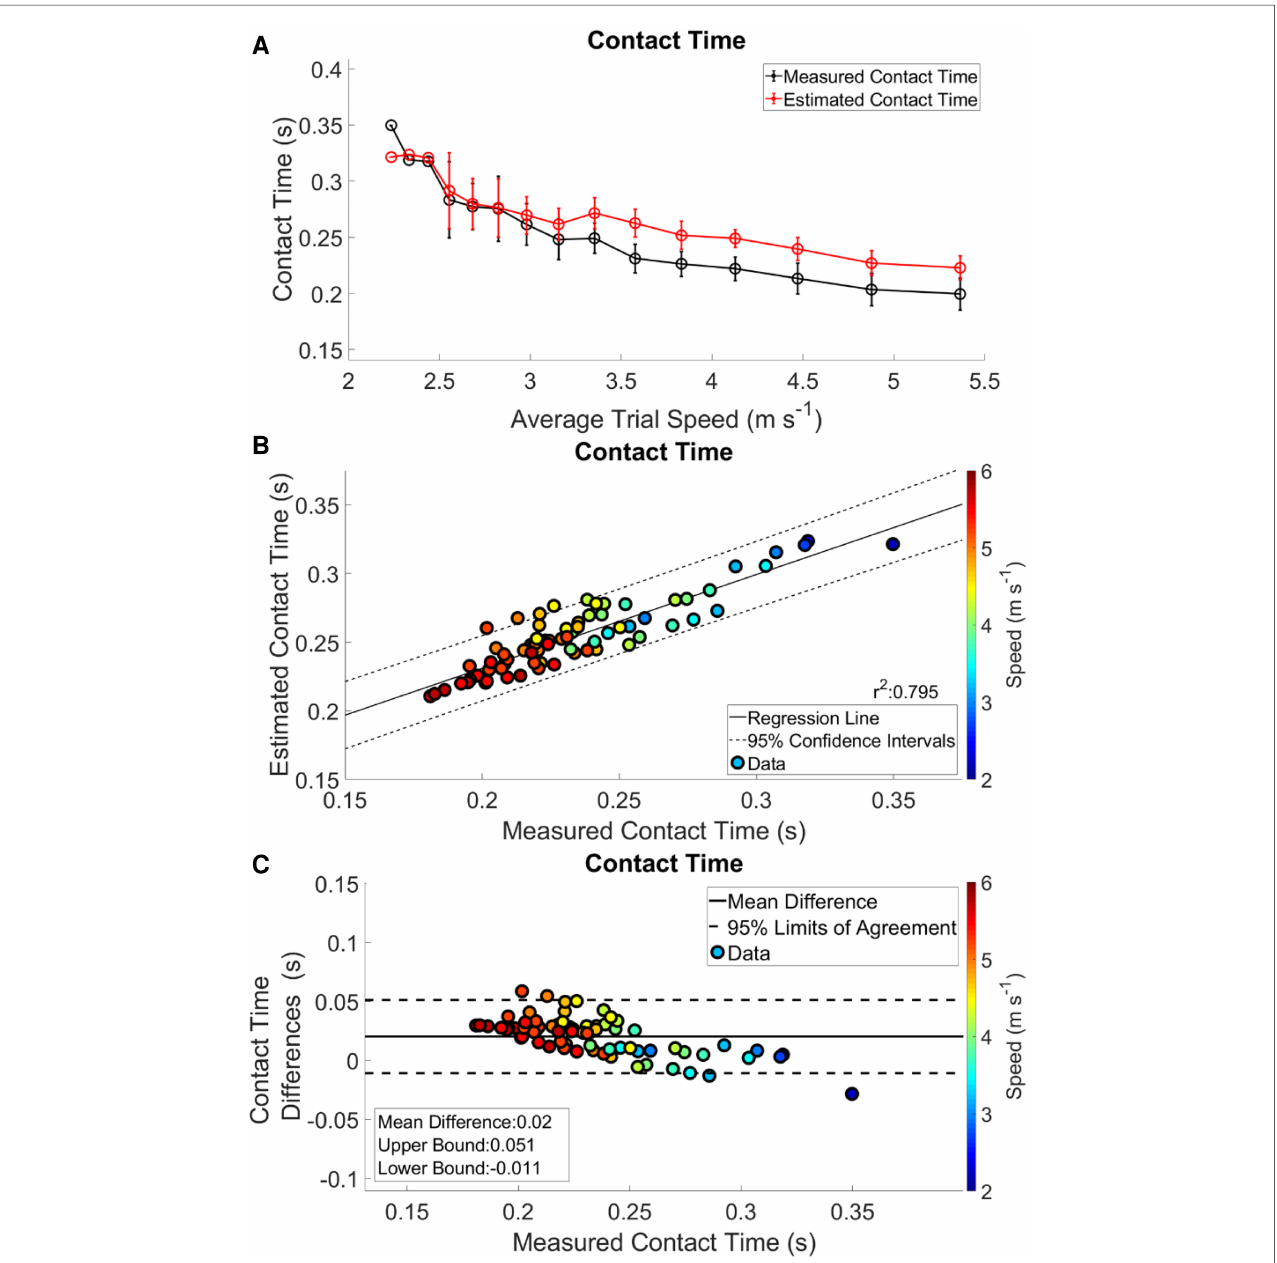
FIGURE 2 Complete analysis of contact time. Panel A shows contact time trends across the range of speeds. The measured contact times are in black and the estimated contact times are in red. Regression analysis and 95% con fi dence intervals of contact time is in Panel B . Panel C presents a Bland-Altman plot of the difference between the estimated and measured contact times, and 95% limits of